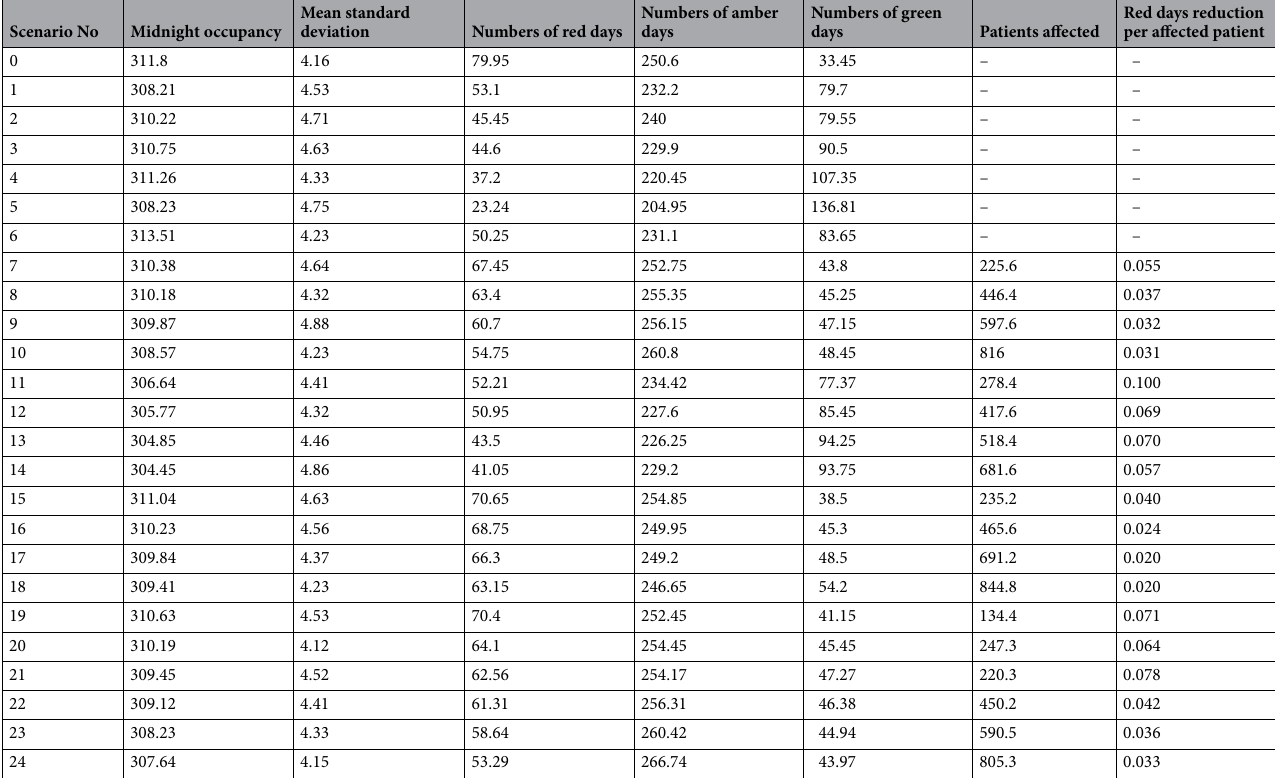
Table 3. The results of scenarios (20